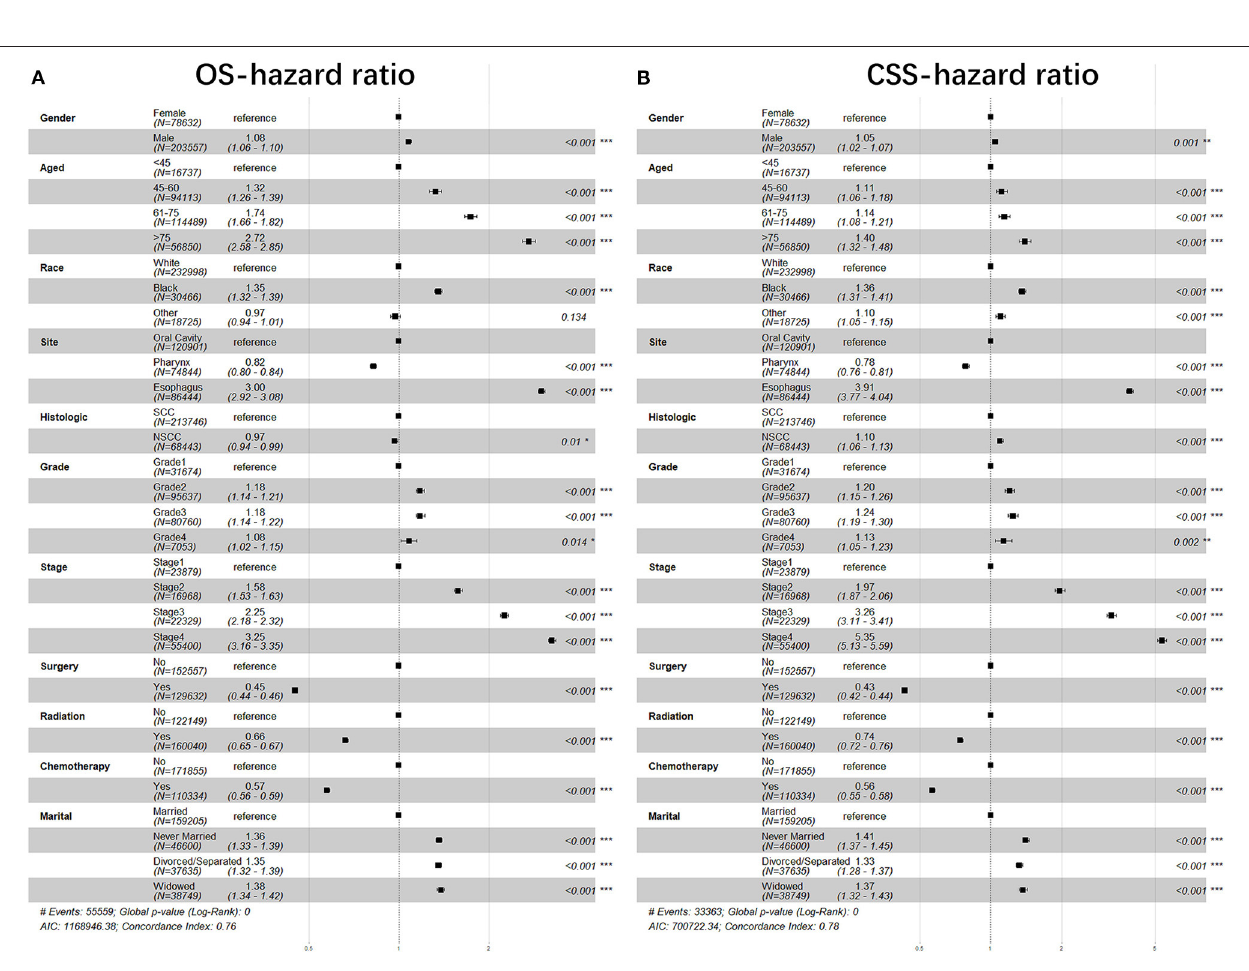
FIGURE 3 | The forest plot of HR (95% CI) for OS and CSS of the patients with UDTT. HR, hazard ratio; CI, confidence interval. (A) OS- hazard ratio; (B) CSS- hazard